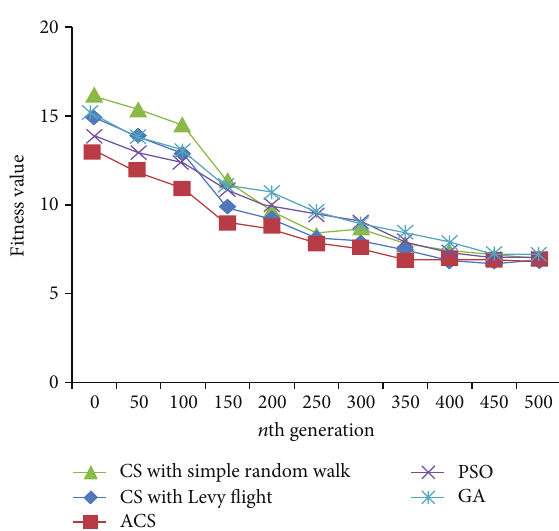
Figure 6: Average execution times (FOAF